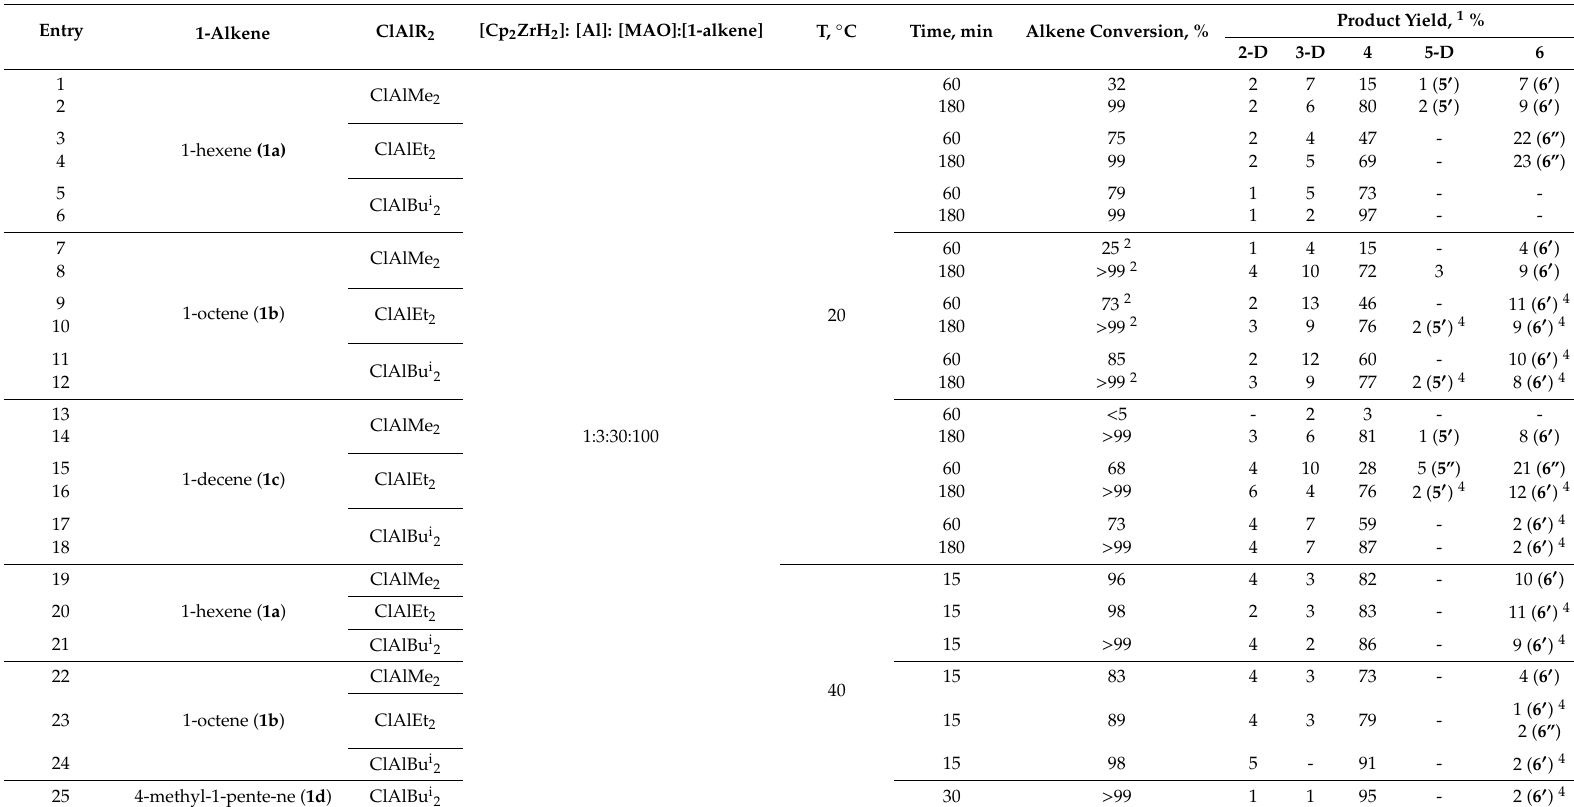
Table 2. Catalytic activity and chemoselectivity of system II [Cp 2 ZrH 2 ] 2 -ClAlR 2 -MMAO-12 in the reaction with terminal alkenes (all ratios are given with respect to monomeric Cp 2 ZrH 2